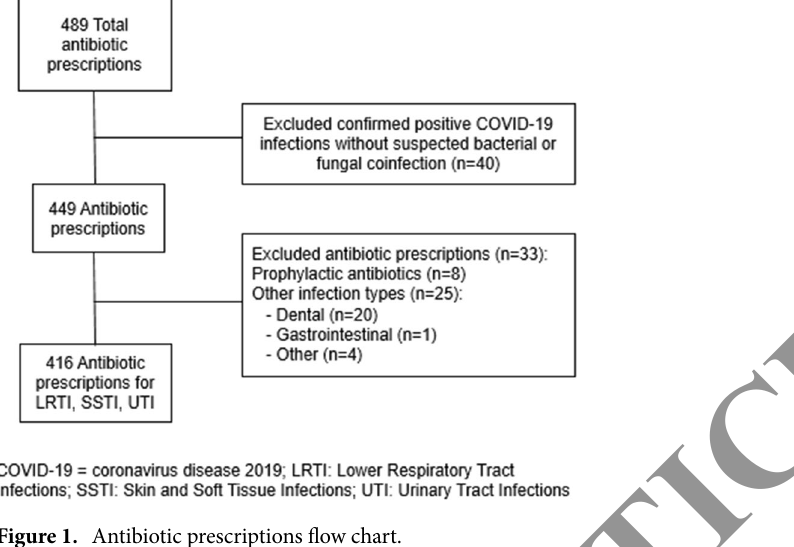
Figure 1. Antibiotic prescriptions flow